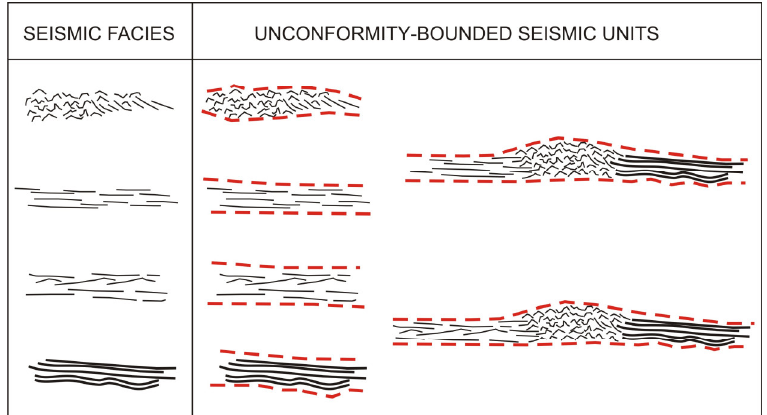
Figure 3. Conceptual scheme of relationships between seismic facies and unconformity-bounded seismic units (UBSUs) applied in this study. The red dashed lines are the unconformity. The symbols of the seismic facies used in this figure are indicative only.